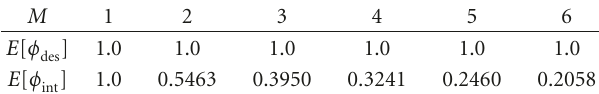
Table 6: Simulation